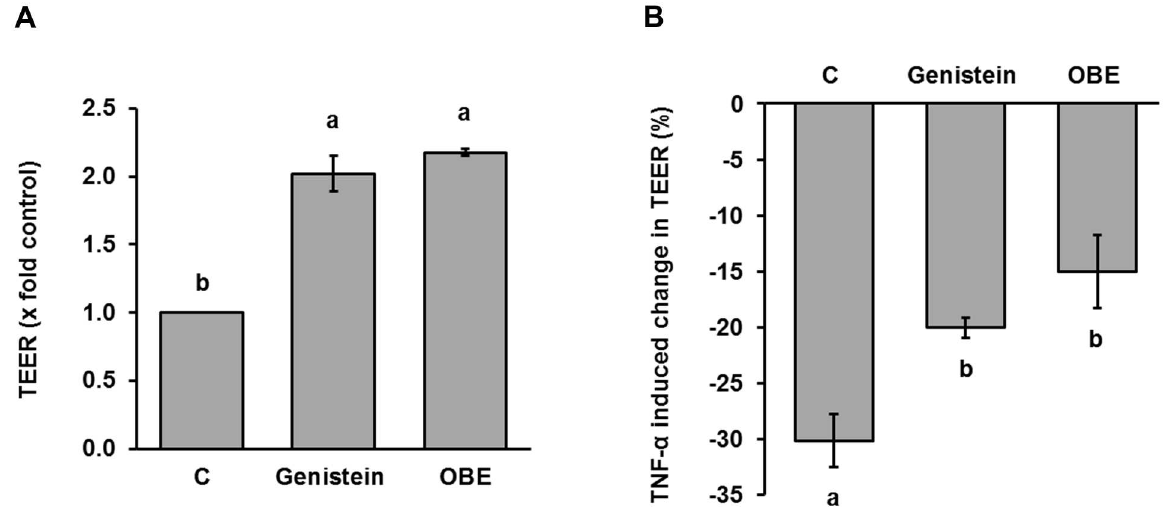
Fig 5. Effect of an olive-oil bioactive extracton basal TEER (A) and TNF- α induced decreasein TEER (B) in vitro . Caco-2/TC-7 cells were allowedto differentiateon permeable filters in the presenceof an olive-oilbioactiveextract (OBE; 100 μ g/mL), genistein (50 μ mol/L; positive control), and DMSO (0.1% v/v; vehiclecontrol [C]) for 5 d. (A) Barrier integrity was assessedby measuring the TEER over time. To investigatepotentialprotective effects of OBE on Caco-2/TC-7 barrier integrity, TNF- α (100 ng/mL) was added to the basolateral side for 24 h on d 5 to inducemonolayerdisruption. (B) TEER was measuredbefore and after TNF- α administration and values were normalized to the untreated control. Bars represent means of 3 individualexperiments ± SEM. Different letters indicatesignificantdifferences amongtreatments ( p <